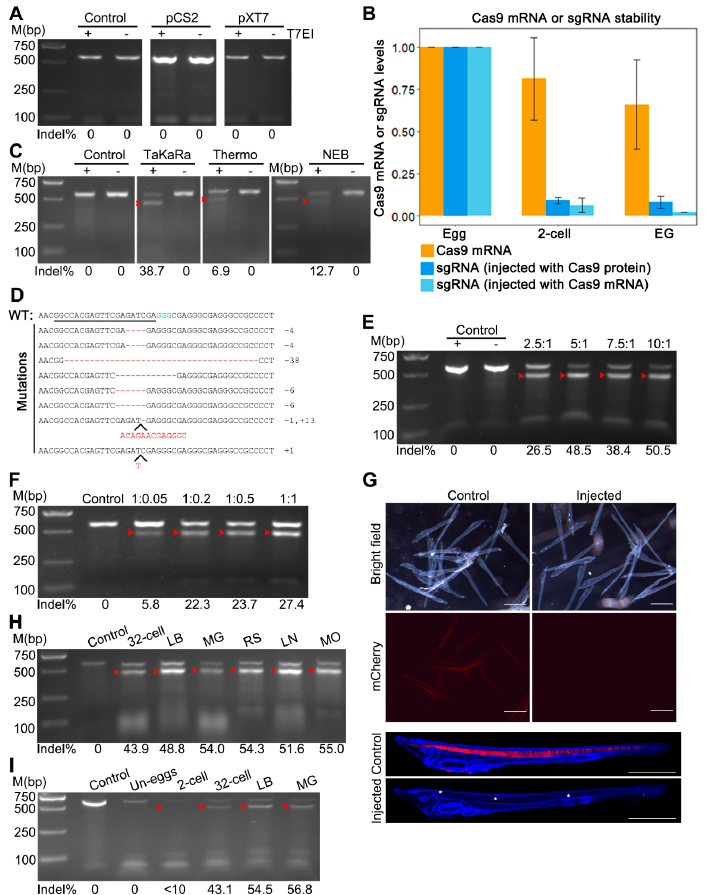
Figure 1 . Detection of CRISPR/Cas9-induced mutations at the mCherry locus in mylz2-mCherry transgenic amphioxus. ( A ) T7EI cleavage assay showing no detectable mutation in uninjected embryos (control), or embryos injected with mCherry -sgRNA and Cas9 mRNA transcribed from pXT7-Cas9 (pXT7) or pCS2-nls-zCas9-nls (pCS2) plasmids. —means no T7 endonuclease I was added and + means T7 endonuclease I was added. ( B ) RT-qPCR analysis of Cas9 mRNA and mCherry -sgRNA expression in embryos injected with Cas9 protein and mCherry -sgRNA or Cas9 mRNA and mCherry -sgRNA. Samples were collected and examined at unfertilized egg (egg), two-cell (2-cell) and early gastrula (EG) stages. ( C ) T7EI cleavage assay showing no detectable mutation in uninjected embryos (control) and di ff erent levels of mutations in embryos injected, respectively, with mCherry -sgRNA and each of the three commercial Cas9 protein (TaKaRa, Thermo and NEB). —means no T7 endonuclease I was added and + means T7 endonuclease I was added. ( D ) Mutations were detected using DNA sequencing in the injected embryos. The wild-type (WT) reference sequence is shown on the top. The underlined sequence is the target site and GGG (green) is the PAM sequence. Deletion is shown by the dashed line and insertion is highlighted by inserted letters. Indels ( + , insertion; –, deletion) are listed on the right of each allele. ( E ) Mutation e ffi ciencies in embryos injected with di ff erent molar ratios of TaKaRa Cas9 to mCherry -sgRNA in which the amount of Cas9 protein was kept constant while that of mCherry -sgRNA was di ff erent. ( F ) Mutation e ffi ciencies in embryos injected with di ff erent molar ratios of TaKaRa Cas9 to mCherry -sgRNA in which amount of mCherry -sgRNA was kept constant while that of Cas9 protein was di ff erent. Red arrowheads in panels C, E, F, H and I mark bands released by T7 endonuclease I digestion. ( G ) Observation of red fluorescent signal in two-day transgenetic larvae. In contrast to uninjected (control) larvae which showed a specific fluorescent signal in the notochord and somites, the injected embryos showed no detectable fluorescent signals. The blue fluorescent signal shows the amphioxus cell nuclei stained with DAPI. Scale bars in all images are 100 µ m. ( H , I ) Mutation e ffi ciencies in di ff erent stages of embryos injected with TaKaRa Cas9 and mCherry -sgRNA. Un-eggs, unfertilized eggs; LB, late blastula; MG, mid-gastrula; RS, rotation stage; LM, late neurula; MO, mouth-opening